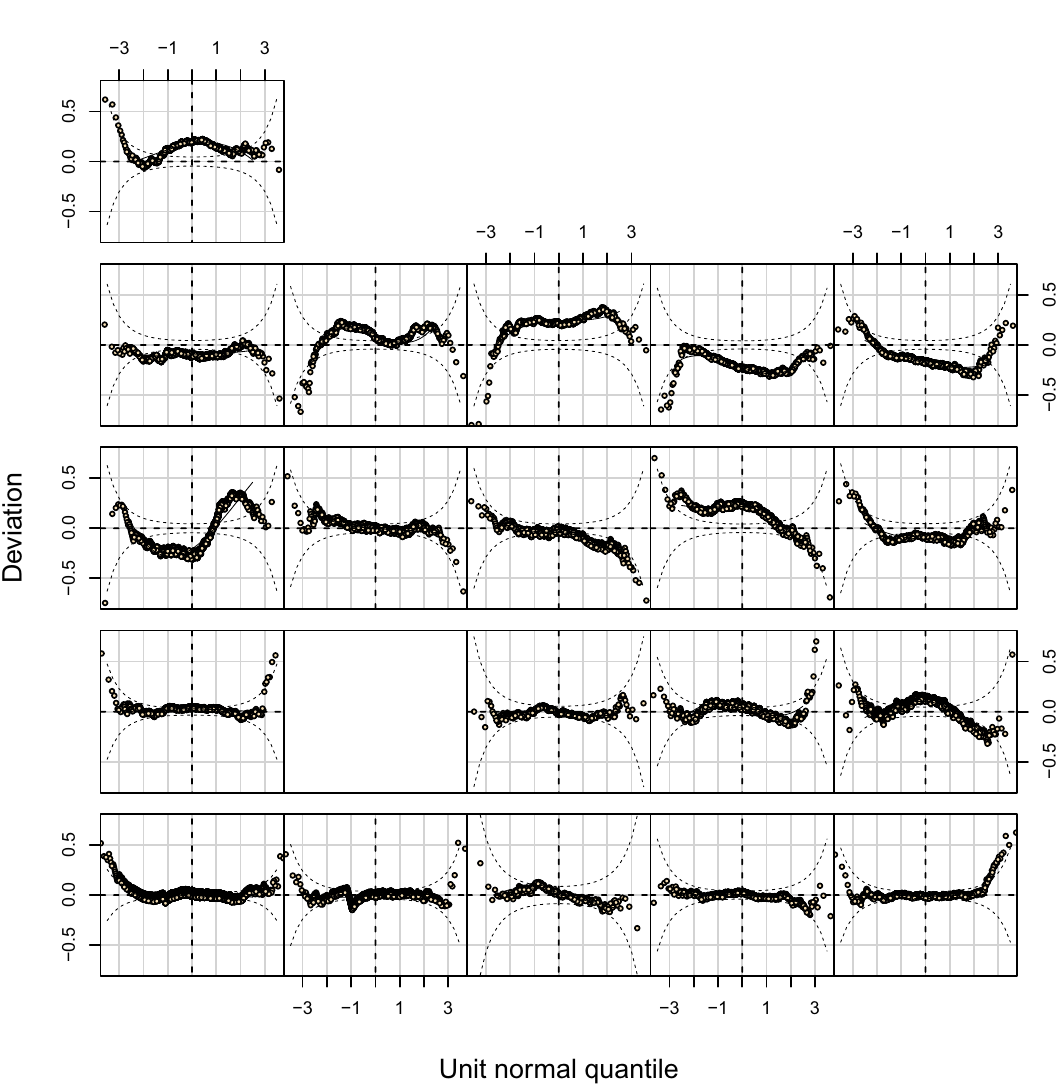
Figure 3. Worm plot for the female piglets for the LMS model. Each panel corresponds to an age bin ordered from bottom-left to top-right, note that the missing panel corresponds to an age bin without observed plots, and visualizing the fitted reference curves and Z-scores. In the modelling phase, a few covariates were considered that could affect the growth pattern: sex, breed, farm of measurement and season of birth. Male and female piglets presented different growth patterns, hence were modelled separately. No differences in the growth pattern were found for the different breeds, and neither for the farms. One of the farms presented a very strong birth season effect, while this was not found for the other farms. Accordingly, the piglets at this farm (i.e. farm C) were not representative for the population and were excluded from being considered in the reference model. . For the final model, the worm plots (Figs. 2 and 3), and the reference curves plotted on the observed data (Figs. 4 and 5) are presented. The worm plots, shown for 23 age groups, present a good fit of the data to the models for both male and female piglets (Figs. 2 and 3). The data points mostly fit the horizontal axis and show only lit- tle deviation. Figures 4 and 5 show that the reference curves follow the observed data nicely. With the reference data, the z-scores can be obtained for the observed data (Fig. 6). The fitted z-scores show that the observed data fit to the model within half a standard deviation. Merely around sixty days the deviation of the observed data to the references from the model is somewhat larger, and between 20 and 50 days there is a gap due to the scarce amount of measurements at these times. Aligning measurement time-points. The first step in the broken-stick model is to decide on the age breaks that should be used in the model. For this data, age breaks were set at day 0, 14, 80, 100, 120 140 and 160. This includes two early ages of interest (0 and 14 days), the age at which the prediction should be made (160 days), and ages in-between for which enough data points were available. The broken-stick model was fitted